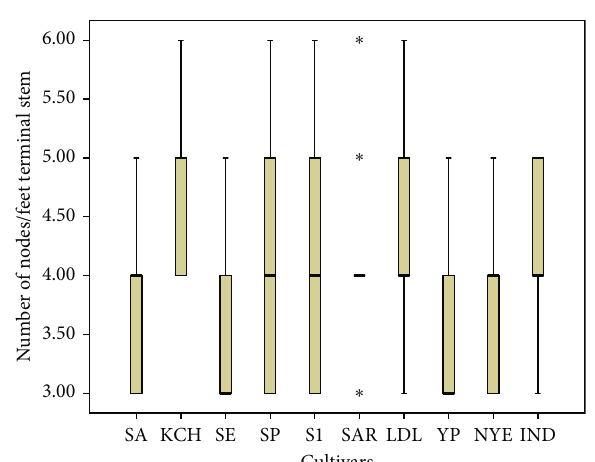
Figure 21: Scree plot showing the cutoff point of extracted components for